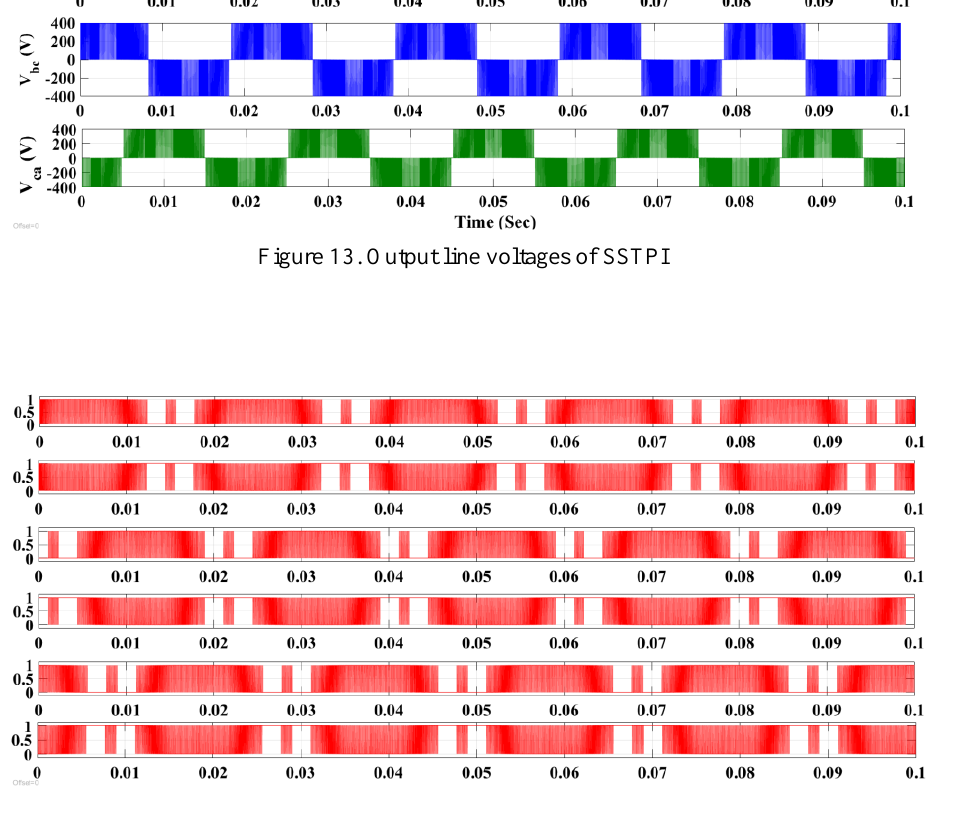
Figure 14. Gate pulses for